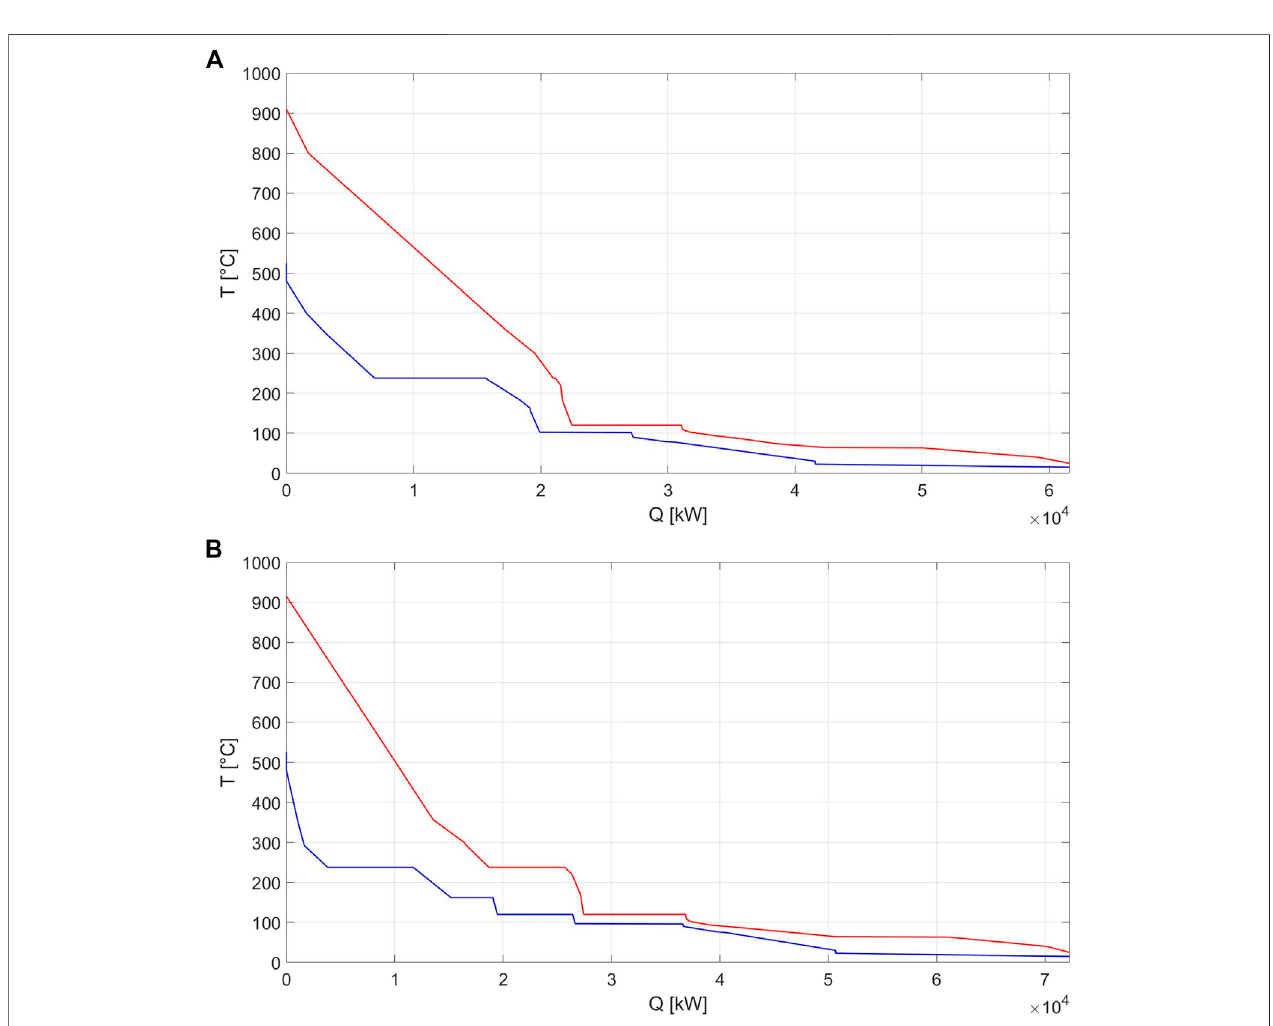
FIGURE 6 | (A) Composite curve of indirect gasi fi cation baseline operation; (B) composite curve of direct gasi fi cation baseline operation.